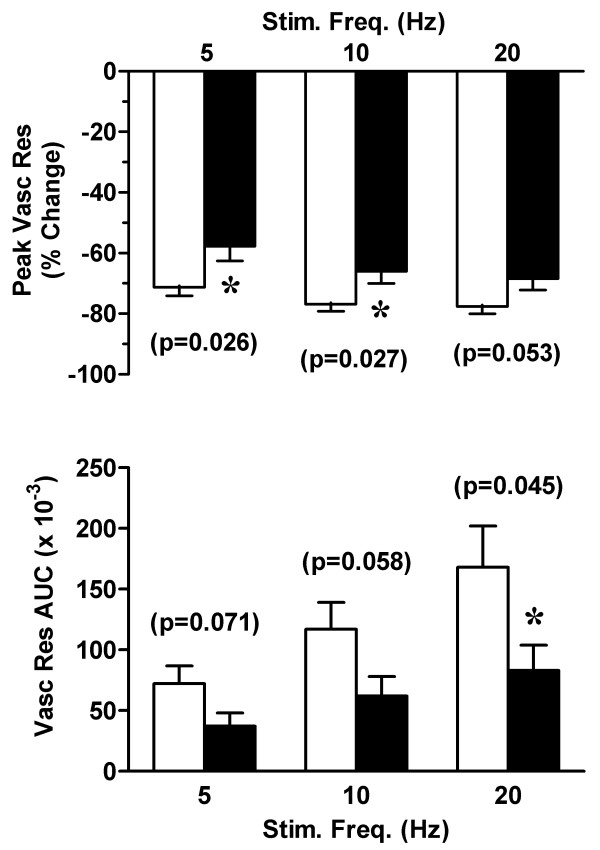
Effect of tamoxifen on vaginal blood flow. In control (empty bars) and tamoxifen-infused (solid bars) rats (see Figure 1), changes in vaginal blood flow were measured by laser Doppler flowmetry. Responses to pelvic nerve stimulation at varying frequencies (5–20 Hz) are expressed as the percent change in peak vascular resistance (relative to baseline values) and the area-under-the-curve (AUC). Data are the mean ± SEM and were analyzed by two-way ANOVA. *p < 0.05 versus control group.